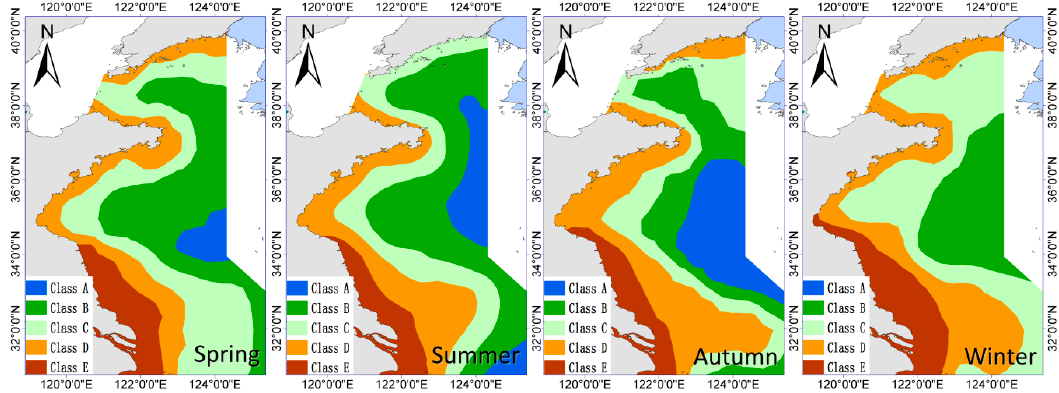
Figure 8. Yellow Sea water class types diagrams for spring, summer, autumn, and winter.